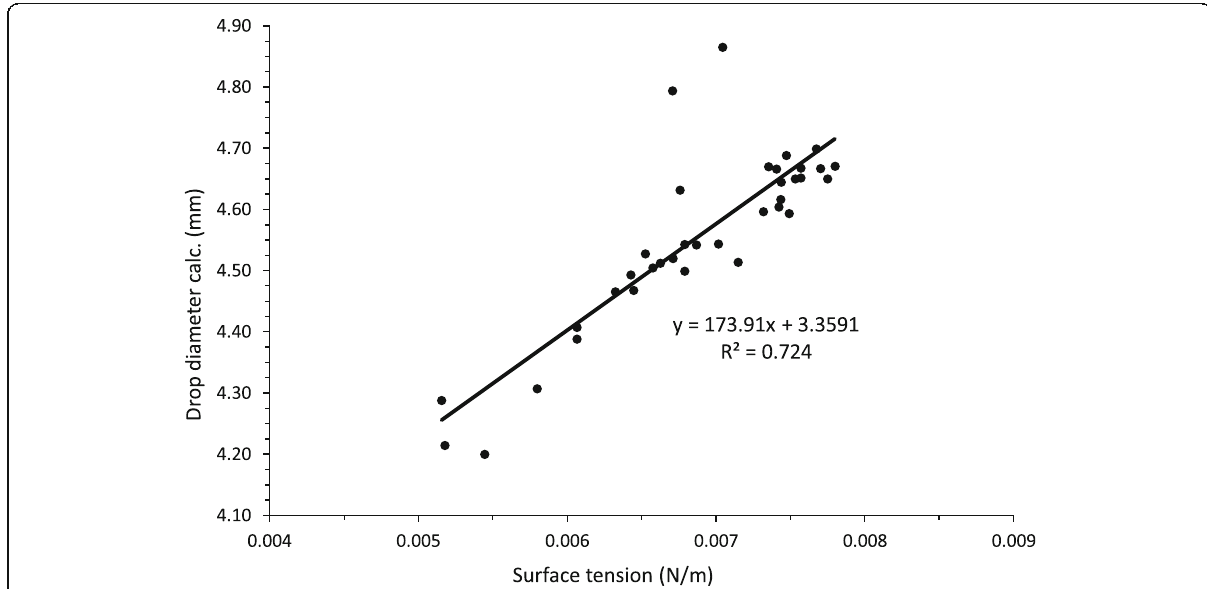
Fig. 2 The relationship between the average surface tensions (N/m) of feed dispersions containing protein:sucrose ratios of 0.75, 1.0, and 1.25, PP contents of 0, 0.5, 1, and 1.5%, and protein isolates including WPI, SPI, and PPI at 25 °C and average calculated diameters (mm) of